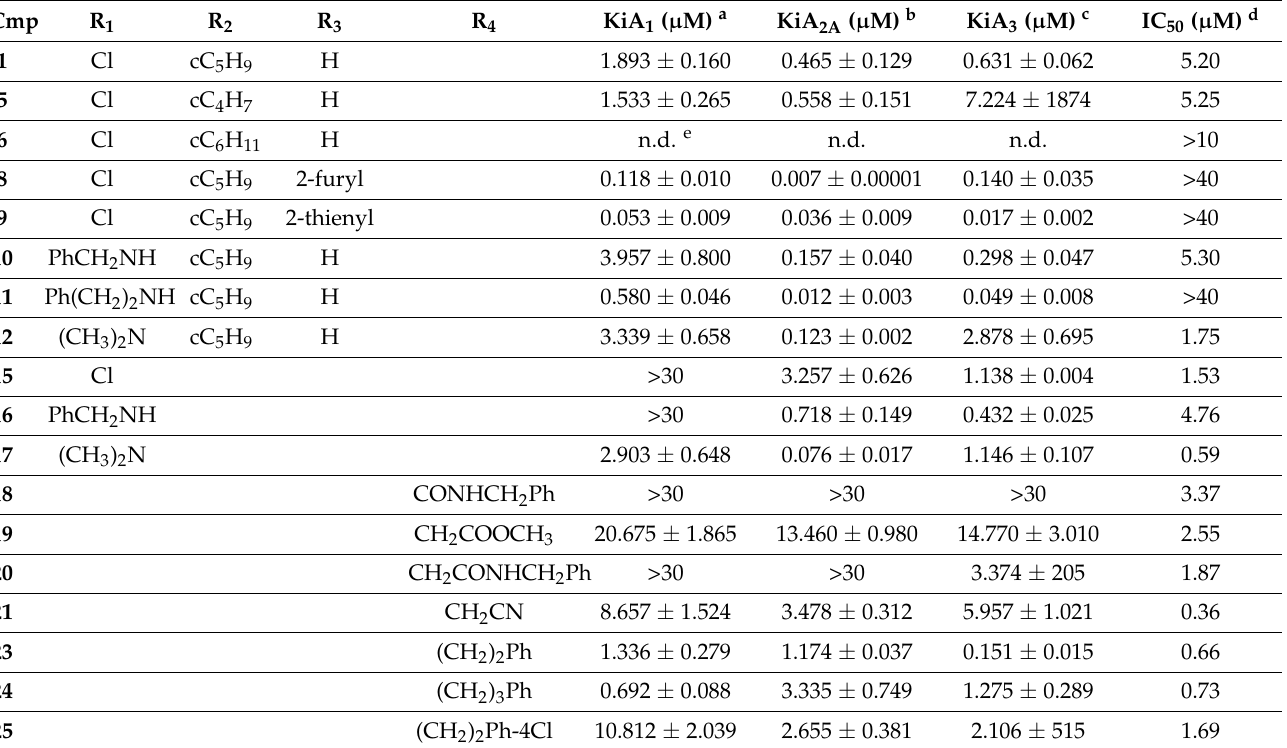
Table 2. Binding data at the A 1 , A 2A , and A 3 ARs of compounds 1 , 5 , 6 , 8 – 12 , 15 – 21 , 23 – 25 at human ARs stably transfected in CHO cells (Ki, µ